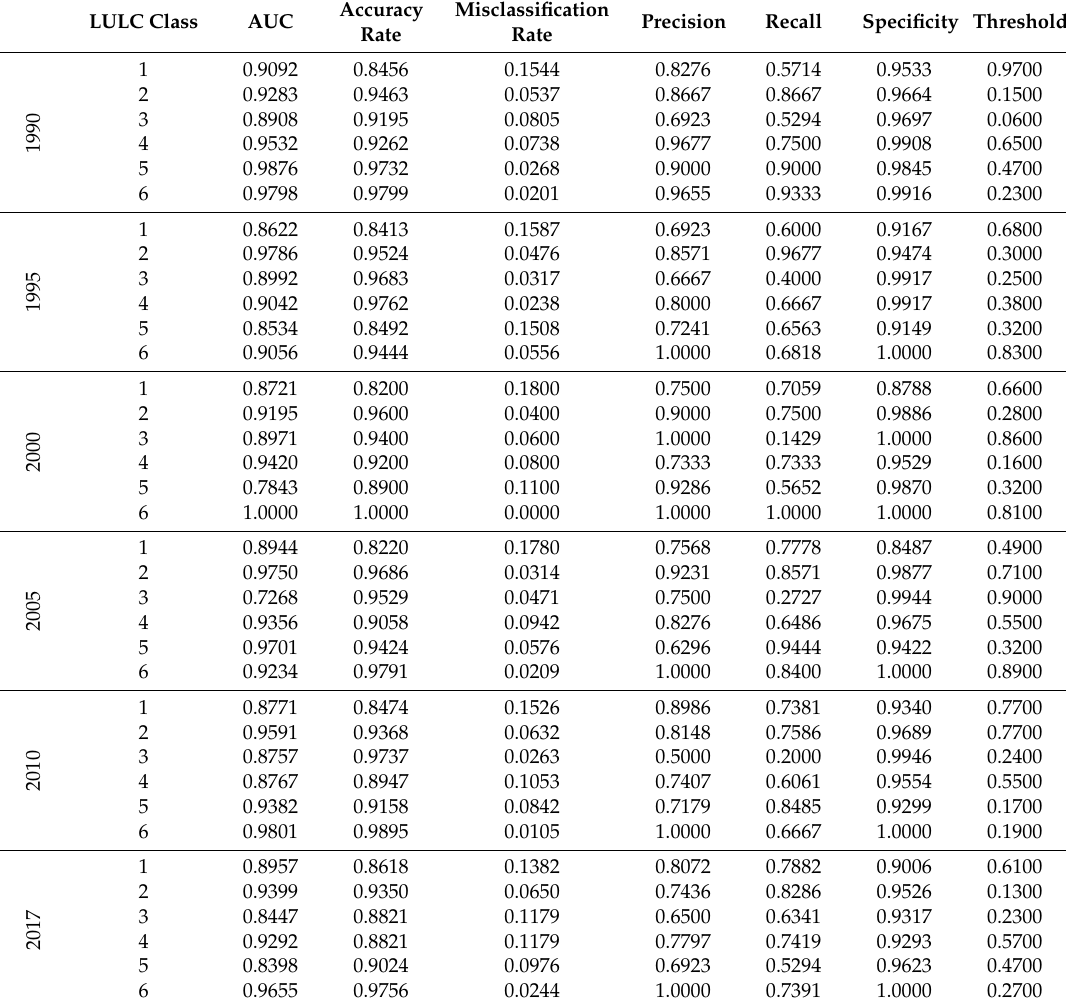
Table 4. Accuracy assessment and precision diagnostics of the XGBoost models for the individual feature classes for each year. Accuracy Misclassification LULC Class AUC Precision Recall Specificity Rate Rate